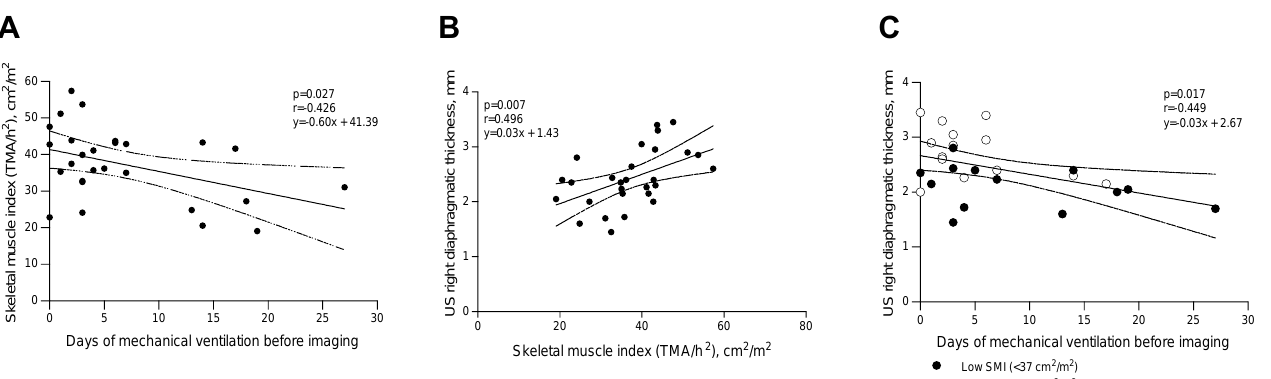
Figure 4. Correlation between days of mechanical ventilation (MV) before imaging and Skeletal Muscle Index (SMI) ( A ); between SMI and US right diaphragmatic thickness ( B ); and days of MV before imaging and US right diaphragmatic thickness ( C ). Definition of abbreviation: SMI = skeletal muscle index; TMA = total muscle area; US = ultrasound.